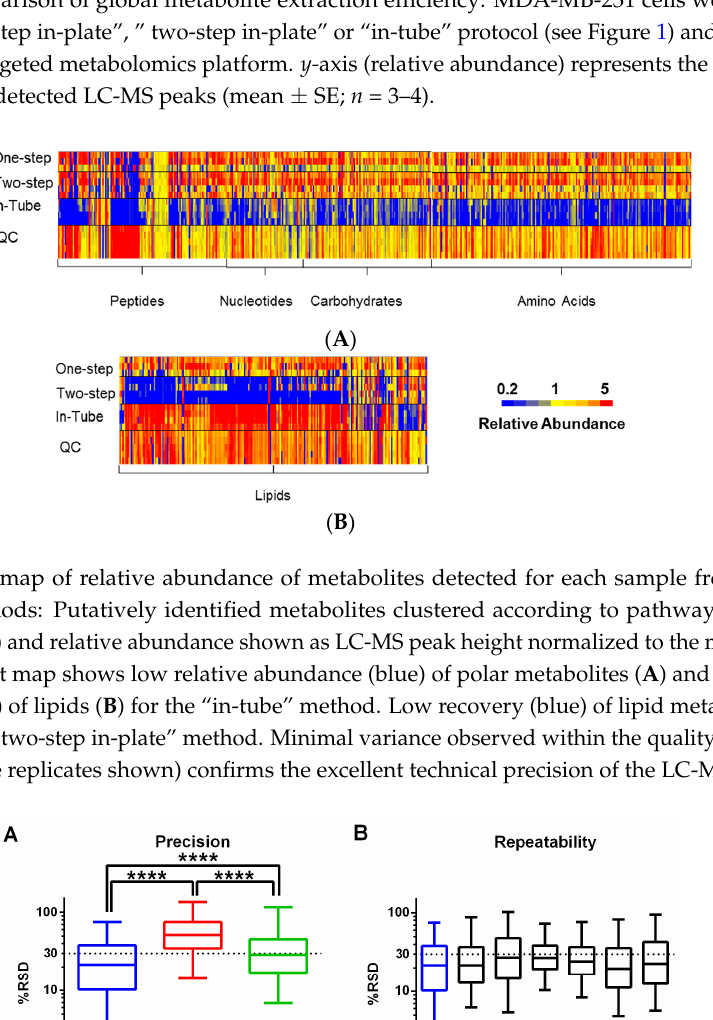
Figure 4. Precision and repeatability of the “One-step in-plate” method: The relative standard deviation (RSD) for each metabolite was determined for: ( A ) each of the extraction methods within a